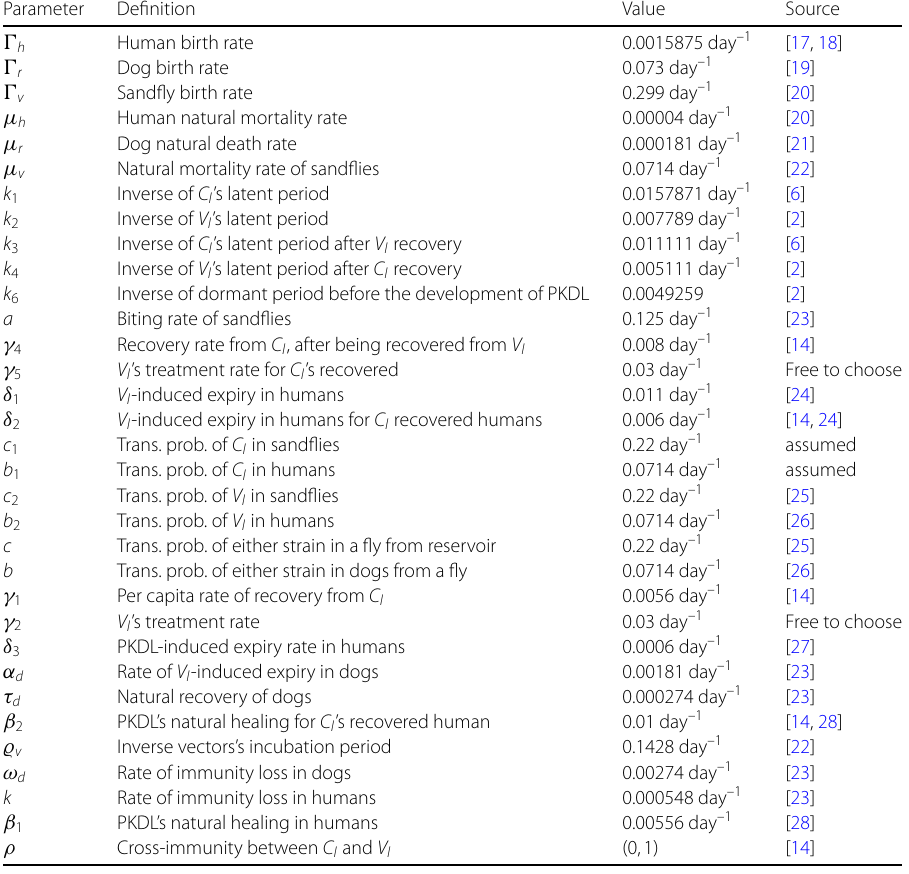
Table 1 Parameter